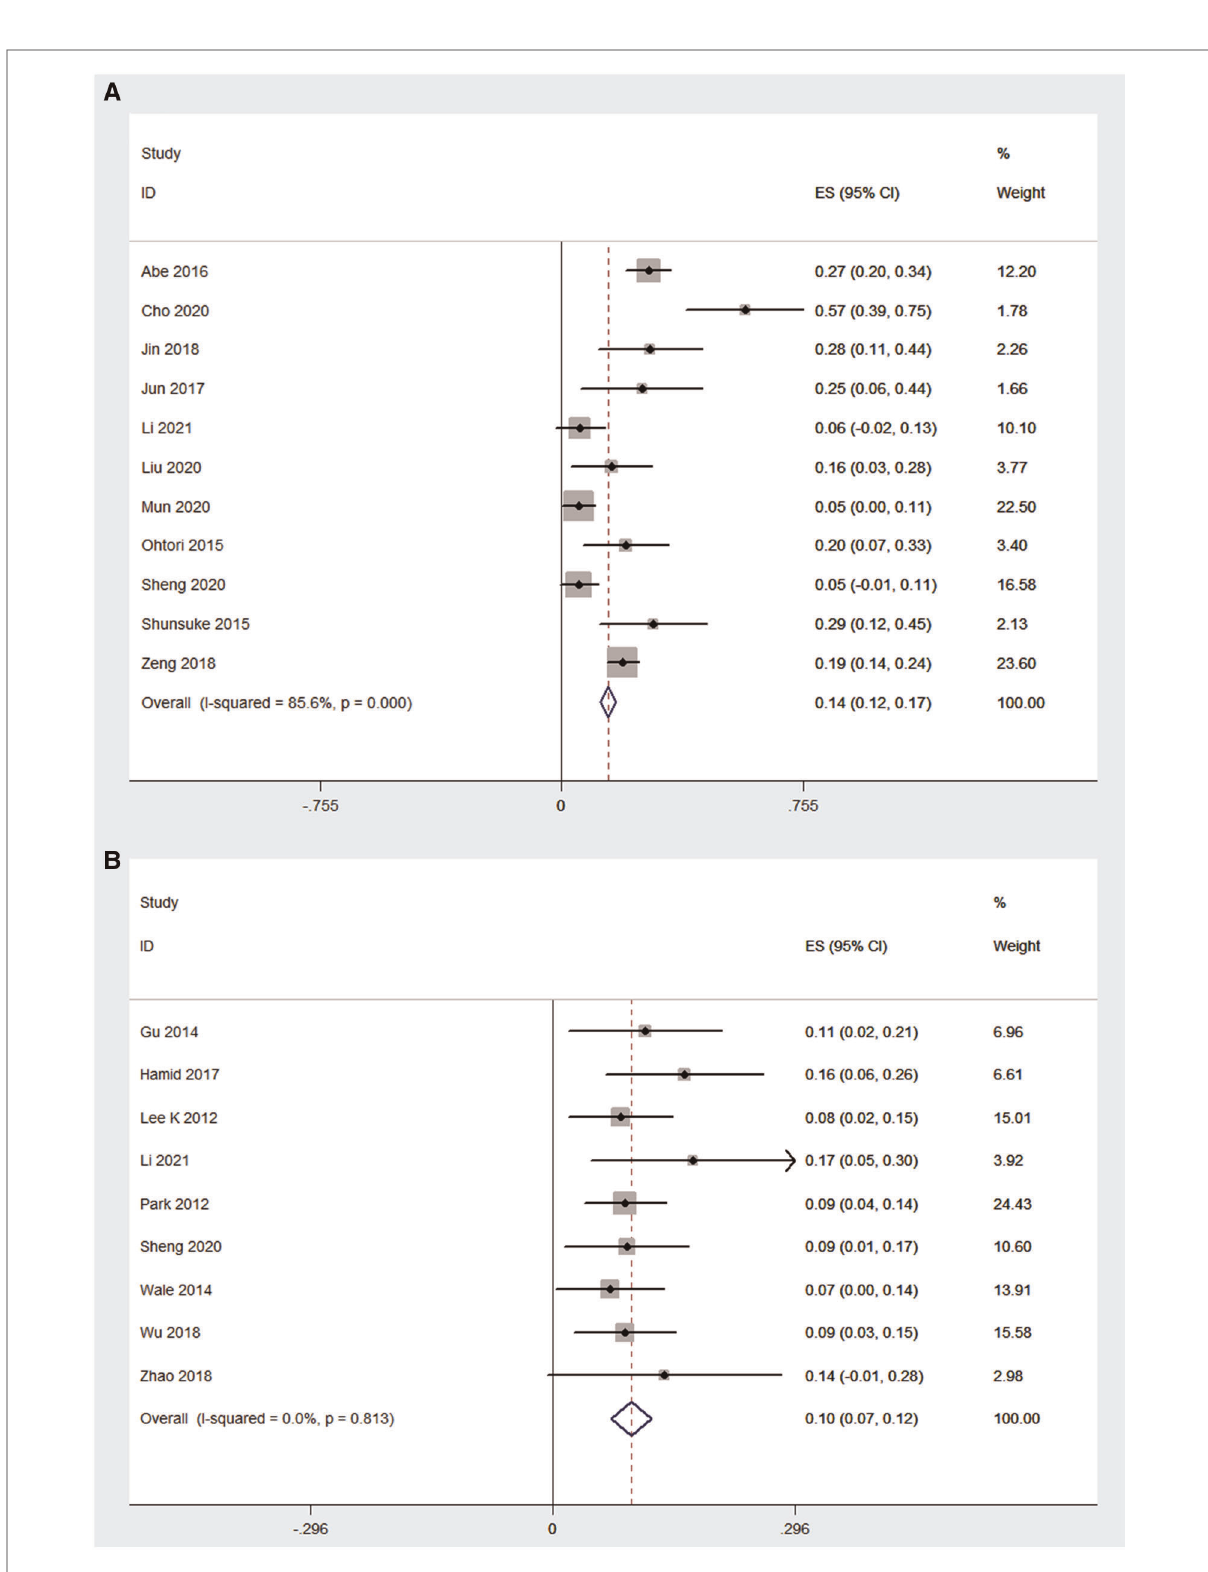
FIGURE 9 Forest plot and pooled estimates of complications. Outcomes assessed are ( A ) OLIF group; ( B ) MI-TLIF